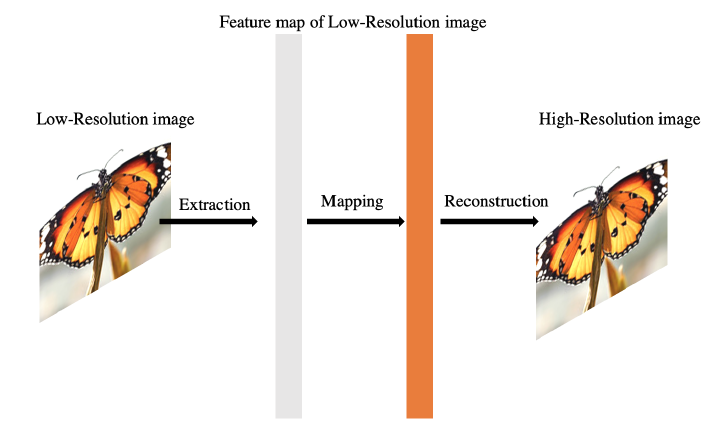
Figure 2. Structure of Super-Resolution Convolutional Neural Network: the first convolutional layer of the SRCNN extracts a set of feature maps. The second layer maps these feature maps nonlinearly as high-resolution patch representations. The last layer combines the predictions within a spatial neighborhood to produce the final high-resolution image